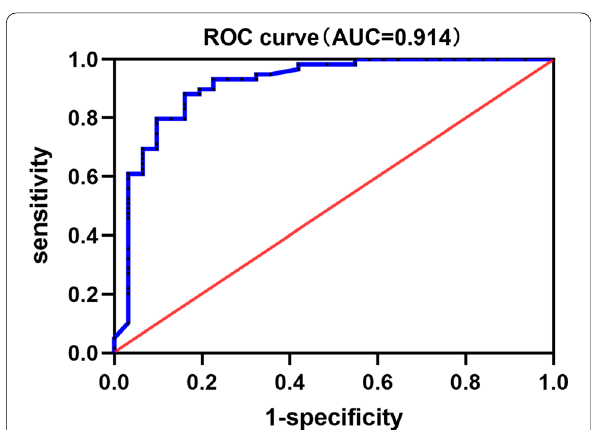
Fig. 5 The area under the ROC curve of multivariate